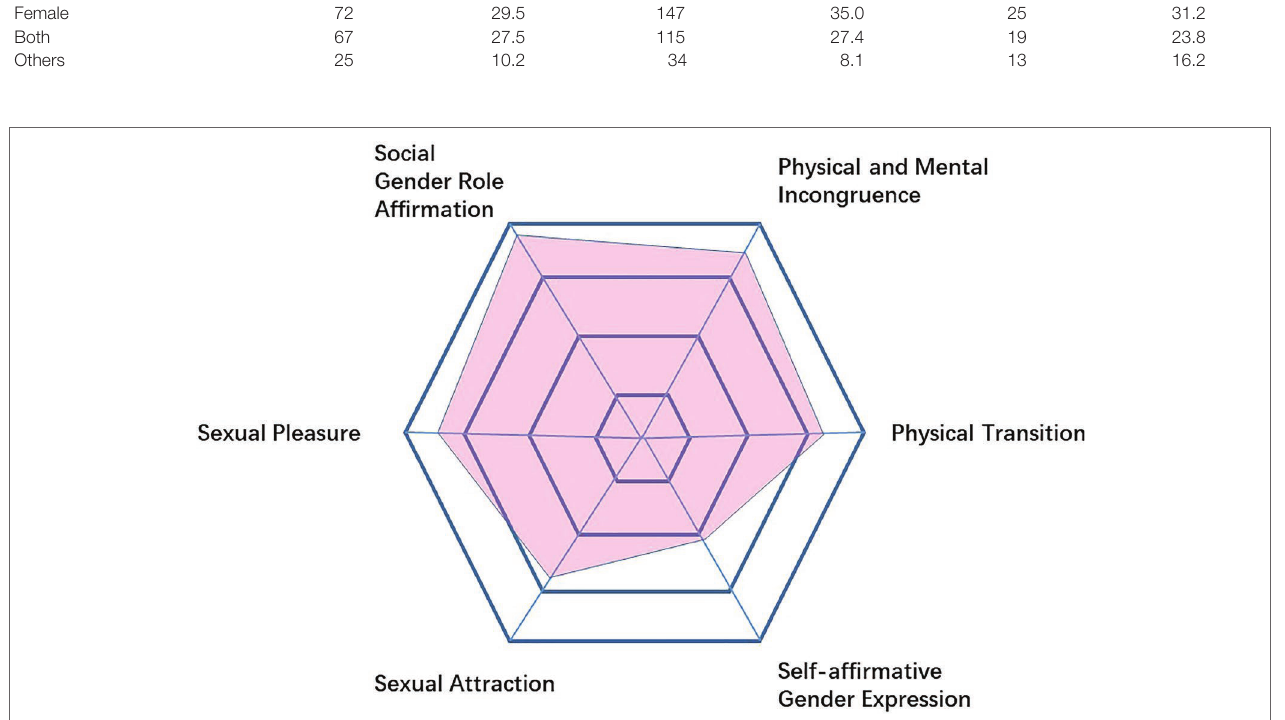
FIGURE 2 | Participants score on six dimensions of